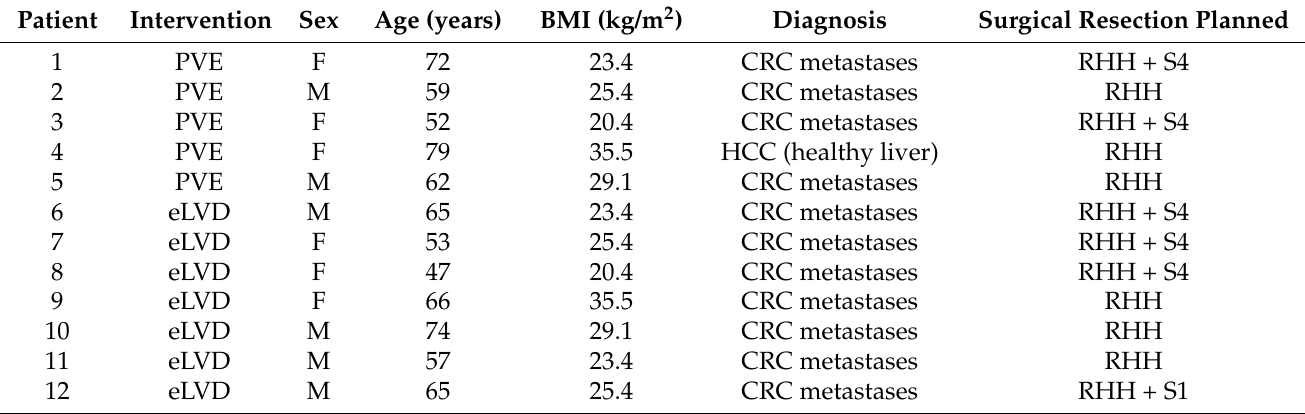
Table 1. Patients’ baseline characteristics.